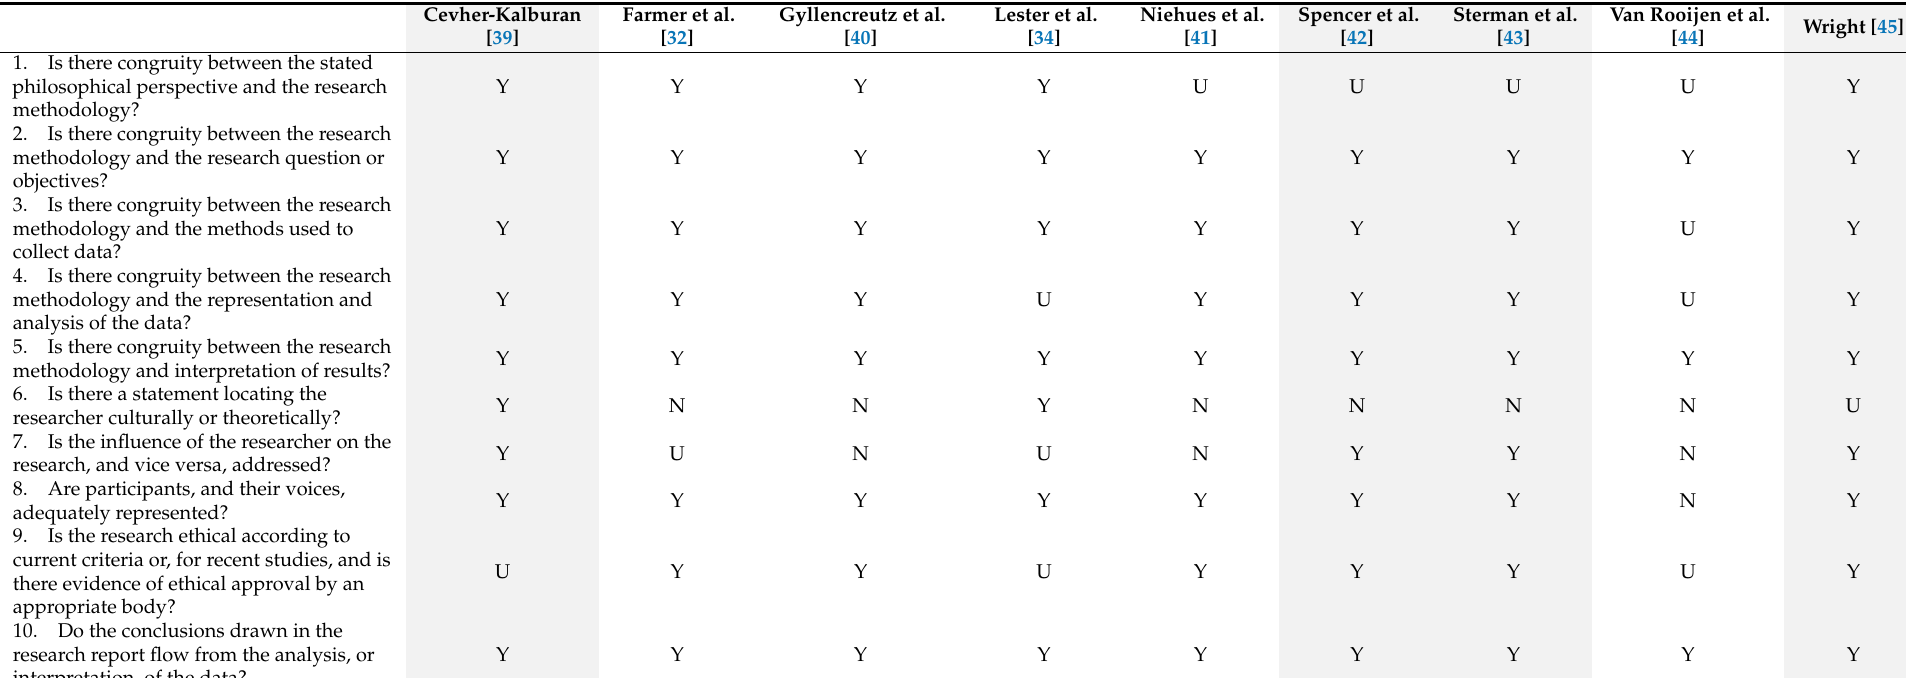
Table 1. Critical appraisal results for eligible studies using the JBI Qualitative Critical Appraisal